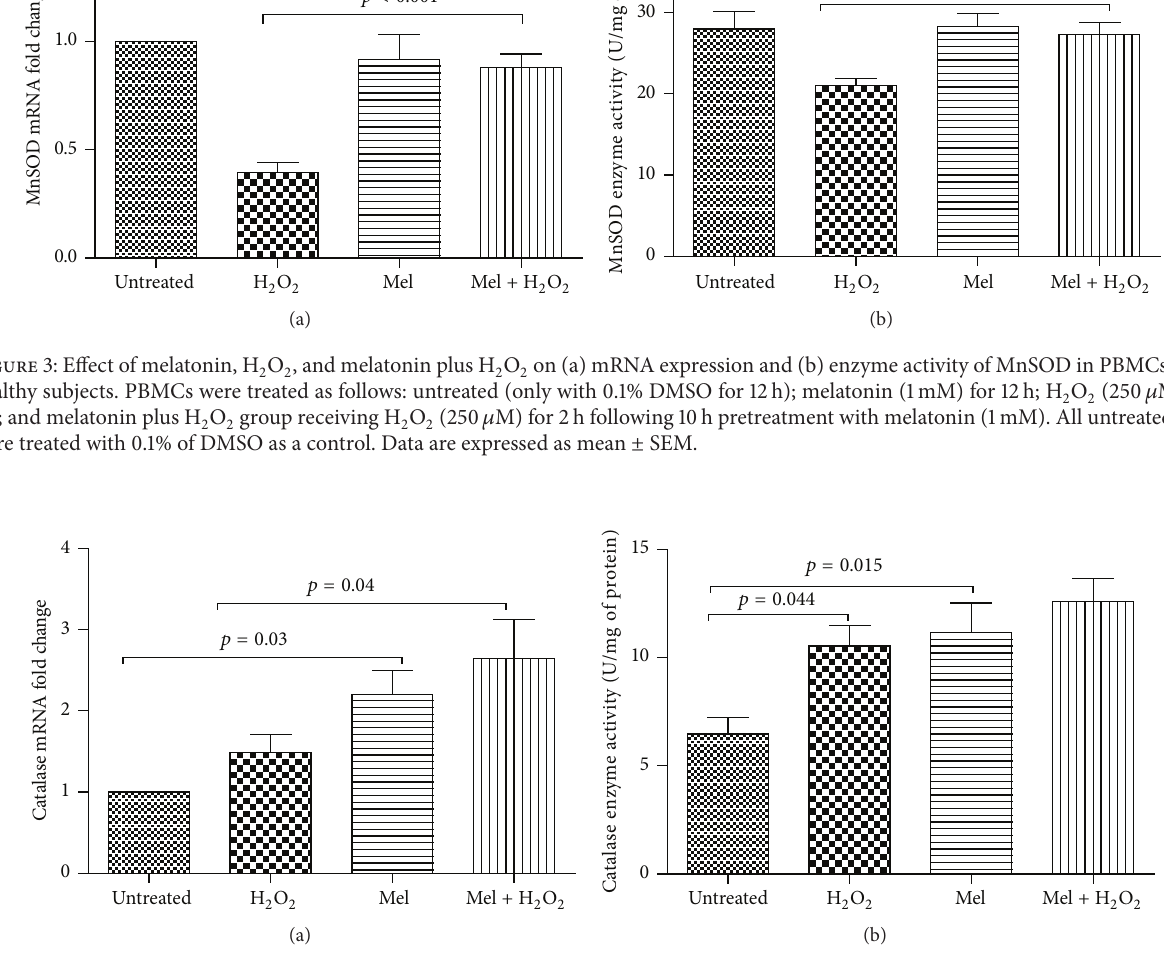
O , and melatonin plus H O on (a) mRNA expression and (b) enzyme activity of catalase in PBMCs from 2 2 2 2 O group receiving H O (250 𝜇 M) for 2h following 10 h pretreatment with melatonin (1mM). All untreated cells 2 2 2 2